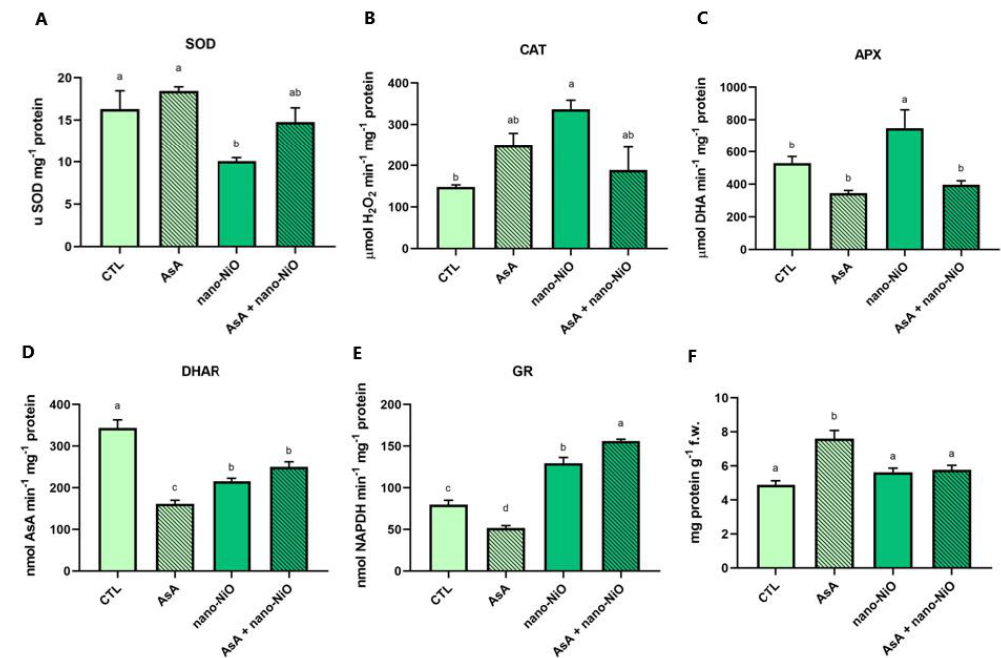
Figure 7. Effects of nickel oxide nanomaterials (nano-NiO; 30 mg L −1 ) and/or ascorbate (AsA, 150 mg L −1 ) on the activity of SOD ( A ), CAT ( B ), APX ( C ), DHAR ( D ), and GR ( E ) and on the content of soluble proteins (F) in the shoots of in vitro grown tomato plantlets. Data presented are mean ± SEM (n ≥ 3) (f.w.: fresh weight). Different letters above bars indicate significant statistical differences between treatments at p ≤ 0.05.